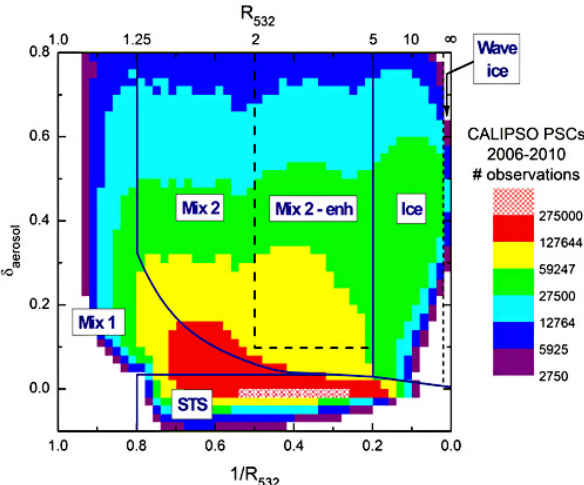
Fig. 1. Composite 2-D histogram of all CALIPSO PSC observa- tions from 2006–2010 in the δ aerosol vs. 1/ R 532 coordinate system, with the solid black lines denoting the boundaries of the four PSC composition domains defined by P09. The histogram bin size is 0.02 × 0.02 and the color scale indicates the total number of cloud observations falling within each bin. The domains of two new composition sub-classes, Mix 2-enh and wave ice, are denoted by dashed